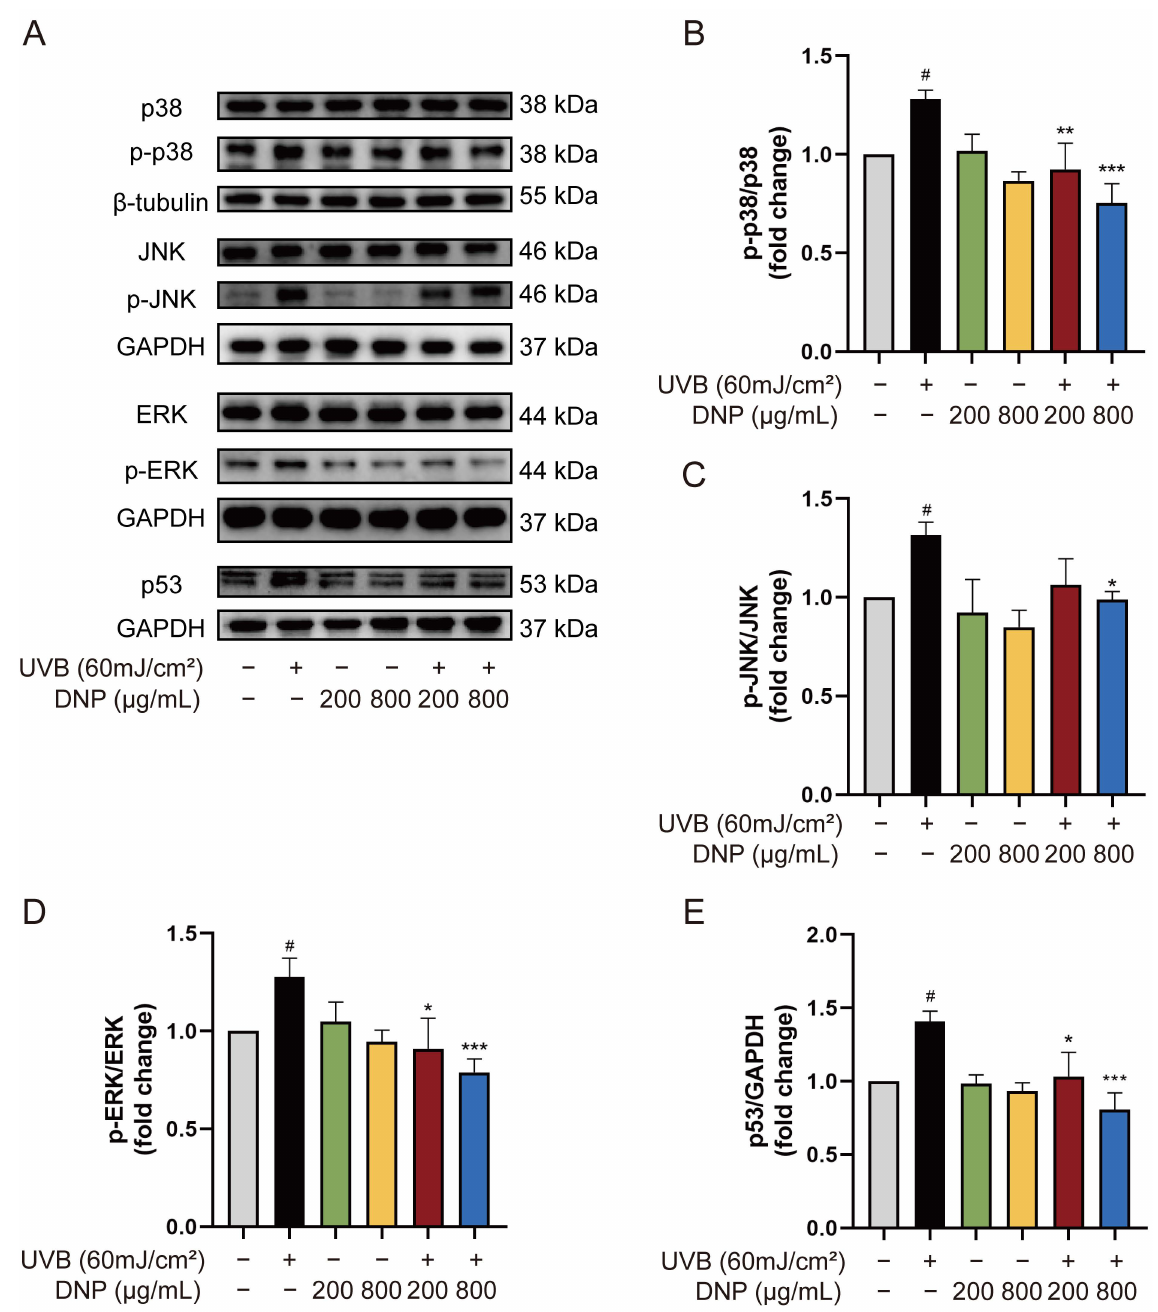
Figure 5. DNPs exert protective effects by regulating MAPK and p53 pathways. ( A ) Protein expression levels of MAPKs and p53. Statistical analysis of the phosphorylation levels of p38 ( B ), JNK ( C ), ERK ( D ), and p53 ( E ). # p < 0.05 vs. control group; * p < 0.05, ** p < 0.01, and *** p < 0.001 vs. UVB